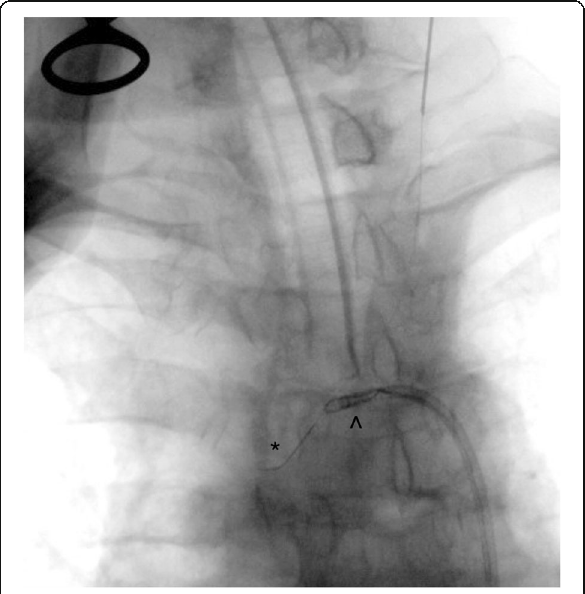
Fig. 2 The glidewire (*) inserted through the CCA puncture site is snared (^) into the Neuron Max. This glidewire is then retracted through the femoral puncture site, allowing control from both